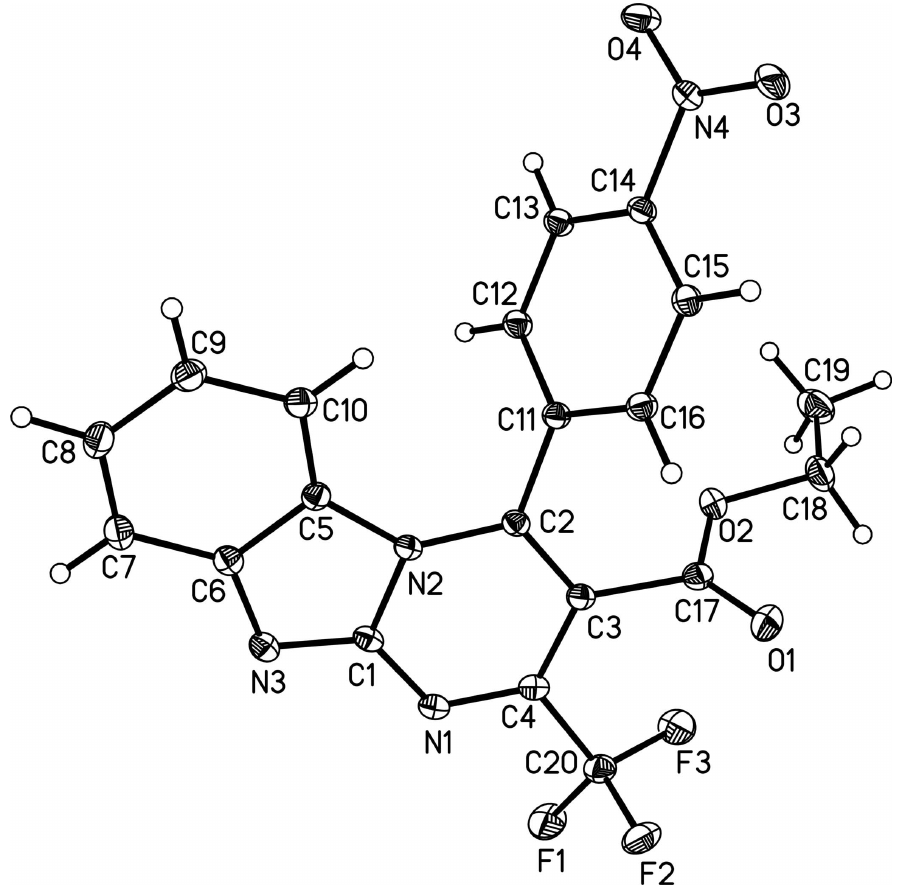
Figure 1 The molecular structure of the title compound, showing 30% probability displacement ellipsoids and the atom-numbering